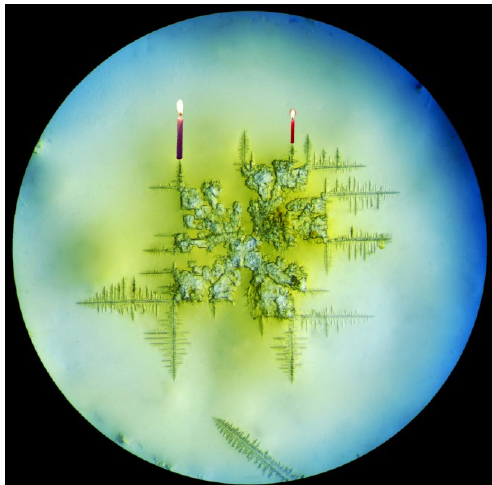
Figure 3. Keren Rot. First Candle of Hanukkah (2015). A photo of a soy sauce crystal (source: courtesy of the